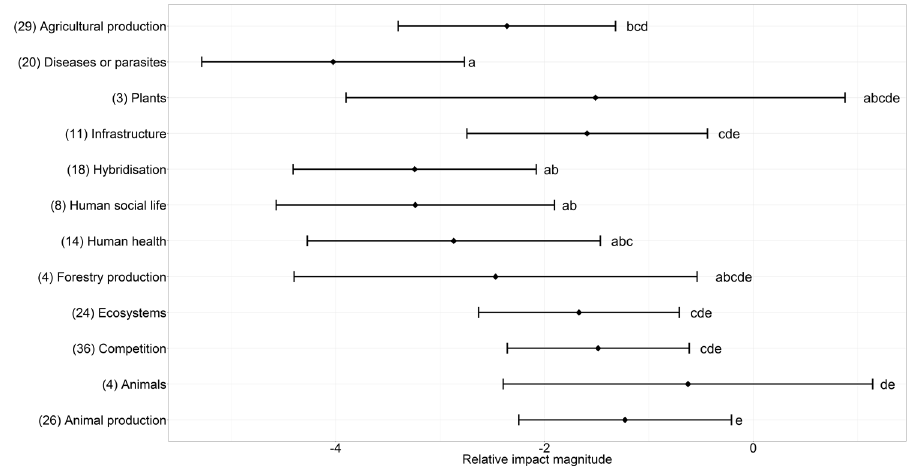
Figure 2. The impact magnitude of the 48 studied alien grasses across different impact mechanisms. On the x-axis are the least-squares means of the impact scores as derived from a cumulative link mixed effects model, and on the y-axis are the GISS impact mechanisms with the number of species in brackets. The points repre- sent the impact magnitudes and the error bars represent 95% confidence intervals. Letters on the right side of the confidence intervals are level groupings indicating significant differences among the mechanisms (level groupings with the same letters are not significantly different, comparisons are Tukey